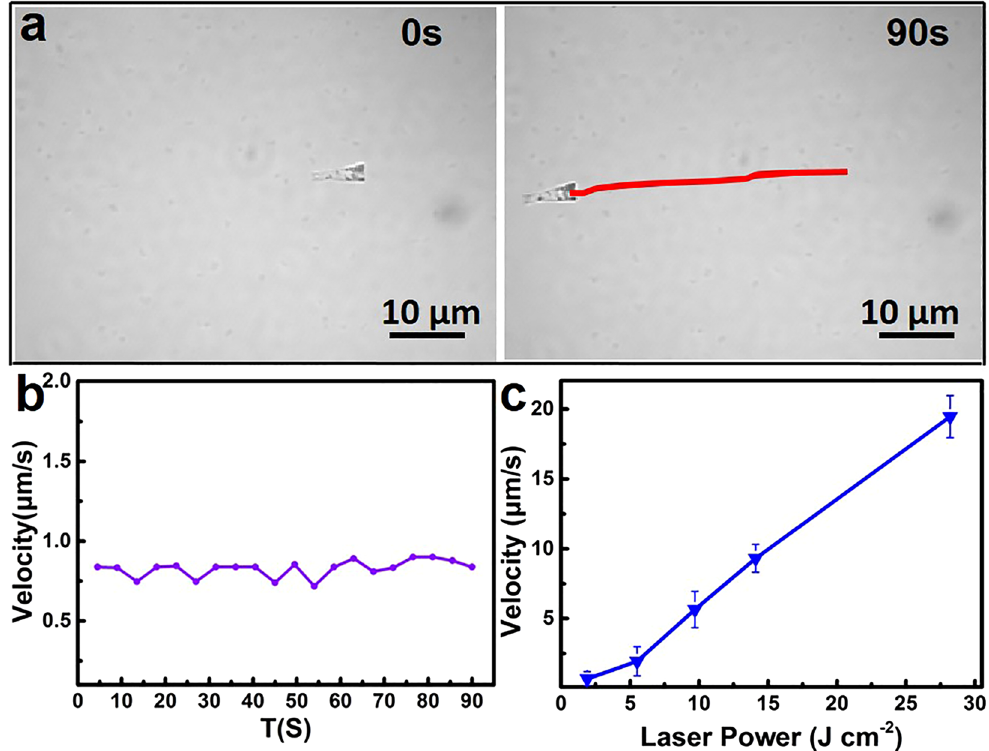
Figure 3. The Movement Behavior of NIR-Propelled Torpedo Motors. ( a ) Time-lapsed images of the torpedo under the NIR irradiation with wavelength of 808 nm in pure water (laser power: 5.5 J cm − 2 ). The red line represents the tracking trajectory of the torpedoes. ( b ) The corresponding velocity of the torpedoes in ( a ) as the function of time. ( c ) The maximal velocity in 1.5 s of ASRs with laser power of 1.9 J cm − 2 , 5.5 J cm − 2 , 9.7 J cm − 2 , 14.1 J cm − 2 , 28.2 J cm − 2